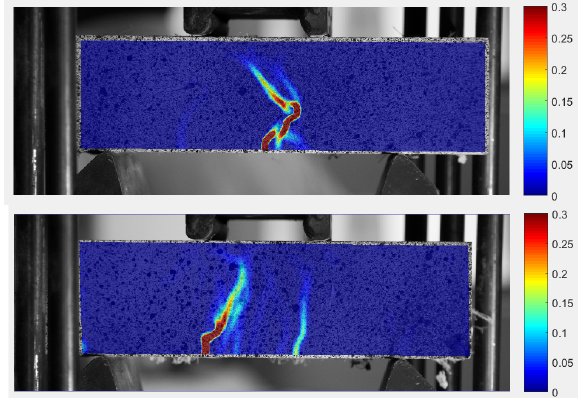
Figure 4. Crack development during four-point bend- ing test of cement sample reinforced with reference (top) and 30 seconds plasma treated (bottom) macro-